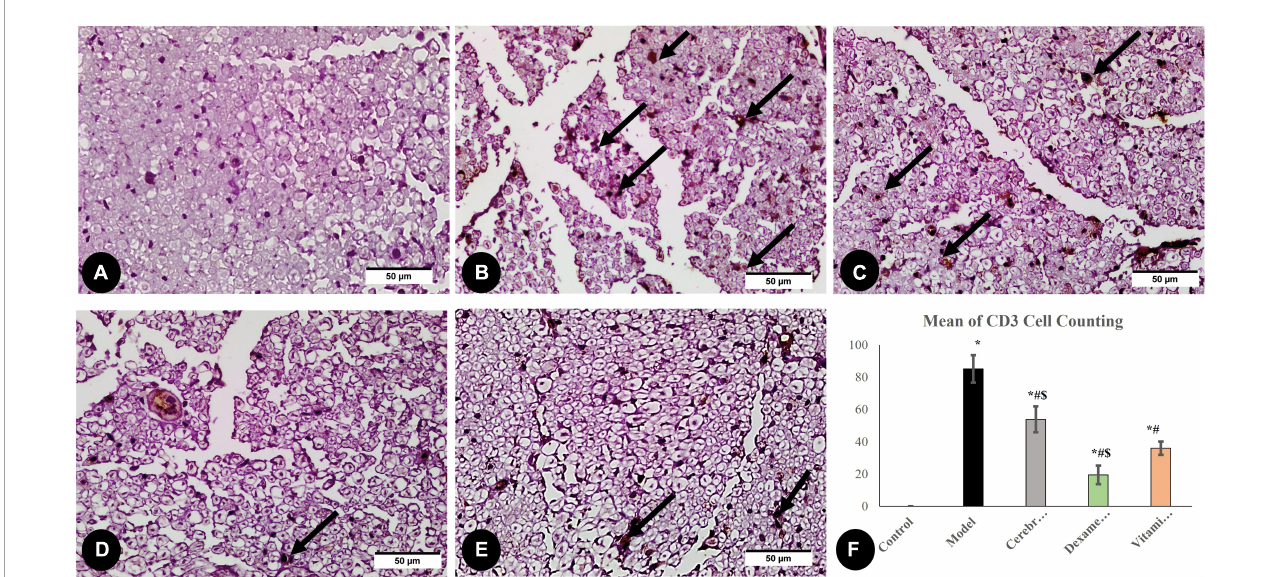
FIGURE7 Immunohistochemical analysis of CD3 marker: in the control group (A) , the model group (B) , the Cerebrolysin group (C) , the dexamethasone group (D) , and the vitamin C group (E) . Arrows point to positively stained cells. (F) Comparison of the expression between different groups. CD3 cell counting was significantly increased in the model group as compared to the control group. The Cerebrolysin group, dexamethasone group, and vitamin C cause a significant decrease in CD3 cell counting correlated with the model group. *Significance as compared to control, # significance as compared to model, and $ significance as compared to Vit C group.